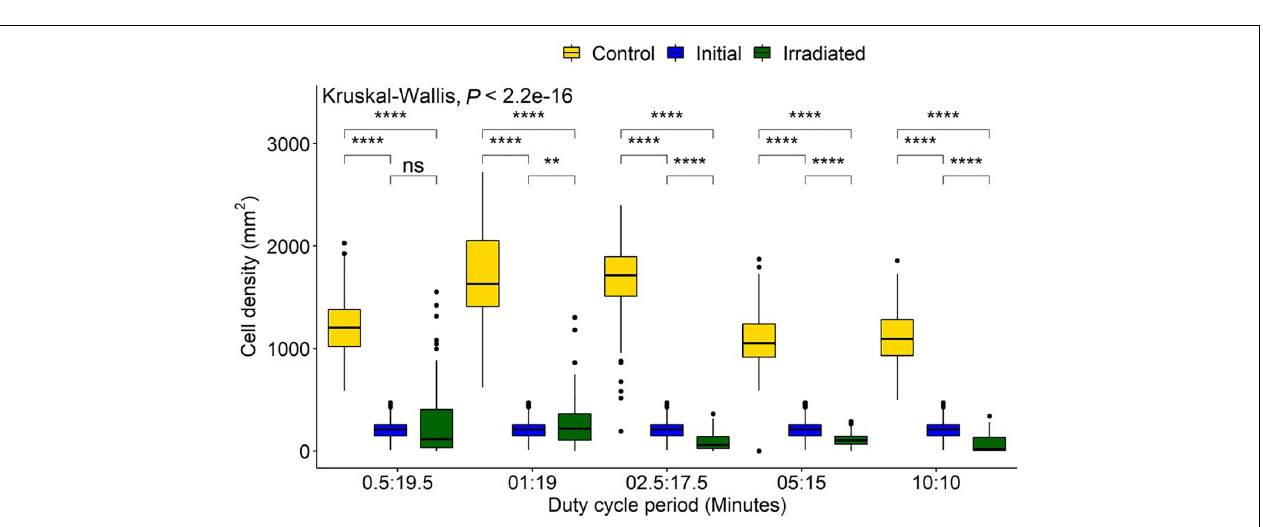
FIGURE 6 | Navicula incerta abundance after UV irradiance over varying duty cycles. Duty cycling periods display minutes in which the UV light was turned on to minutes it was turned off (On:Off). Fluences were determined as 0.47, 0.94, 2.34, 4.68, and 9.35 J/cm 2 for each respective duty cycle 0.50:19.50, 1:19, 2.50:17.50, 5:15, and 10:10 (irradiated: no irradiance). Significant differences indicated via Wilcoxon pairwise comparison above groupings (ns, no significance, ** P < 0.01, **** P <